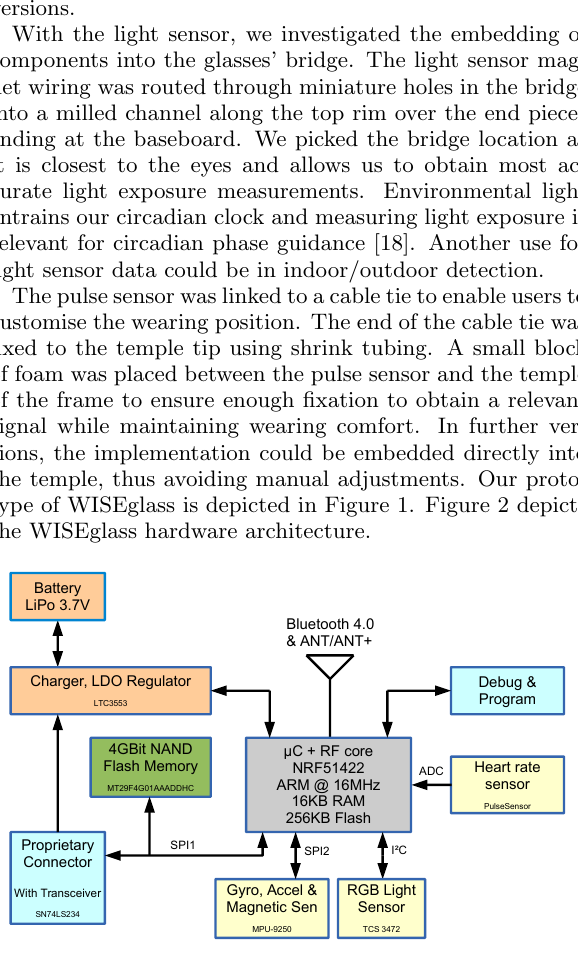
Figure 2: WISEglass hardware architecture. Sepa- rate SPI busses are used for communication of the main controller unit (MCU) with the flash memory and the inertial measurement unit to optimise data throughput.